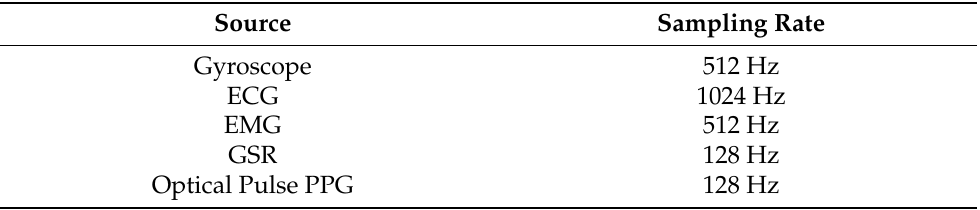
Table 6. Shimmer Sensor Specification.